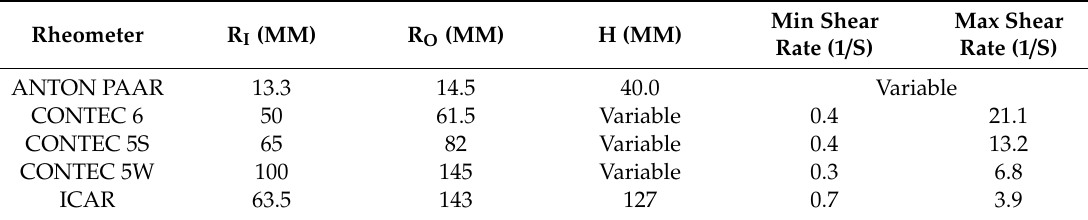
Table 6. Dimensions, minimum and maximum shear rate of each